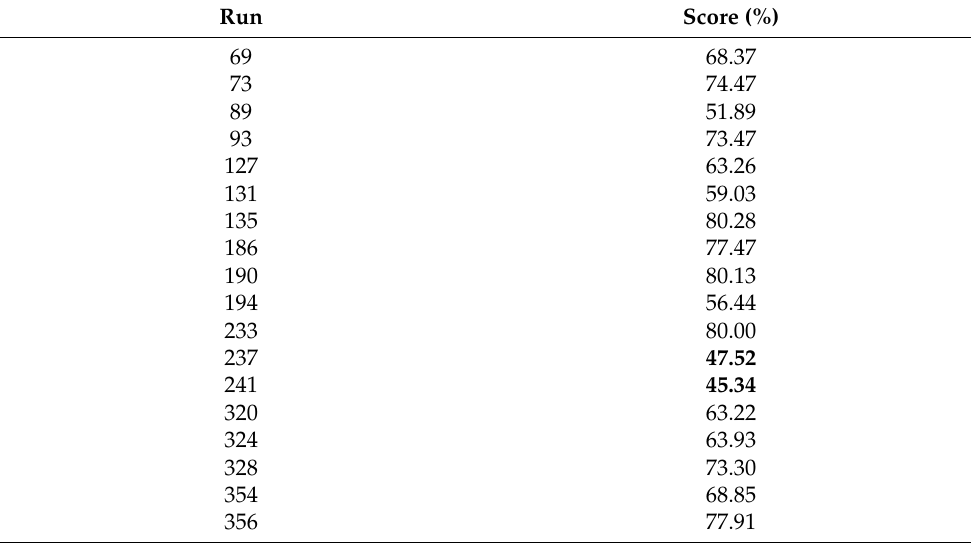
Table 2. Average scores for each run of the machining